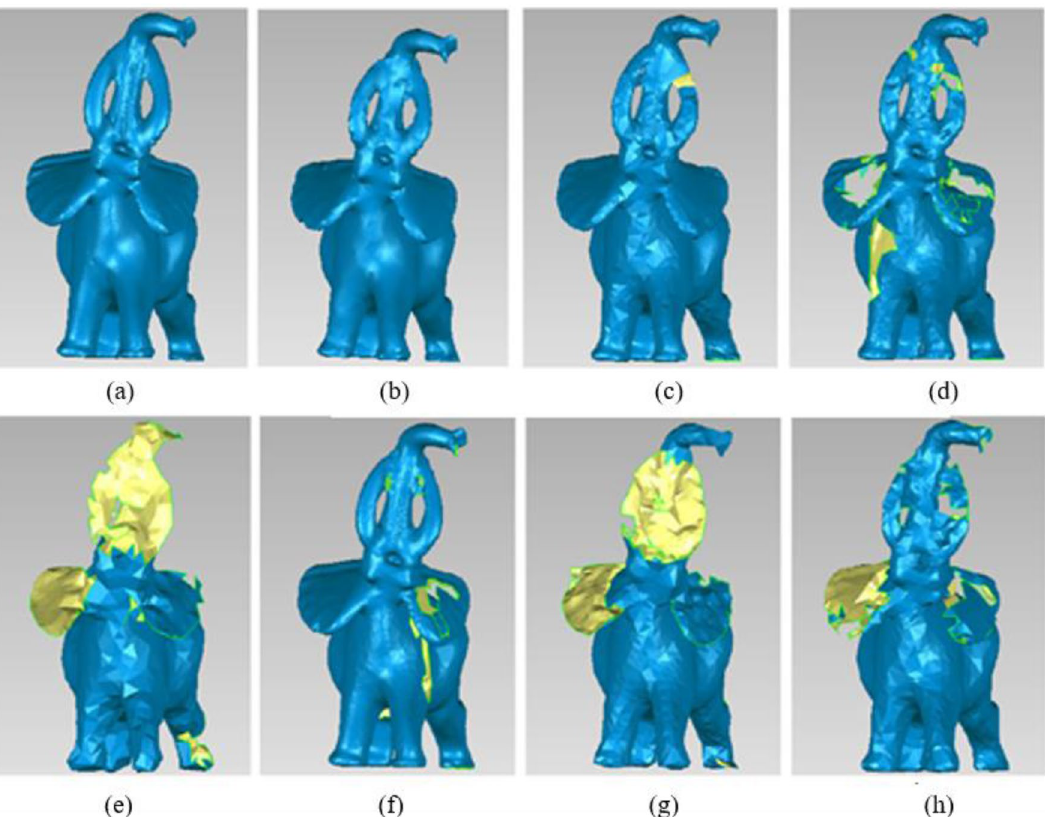
Figure 13. Different simplified results of Elephant. ( a ) Original data. ( b ) Our method. ( c ) The simplified method based on DFPSA. ( d ) The simplified method based on Gaussian spheres. ( e ) The simplified method based on octree coding. ( f ) The k-means clustering simplification method. (g) The uniform simplification method. ( h ) The geometric algebra